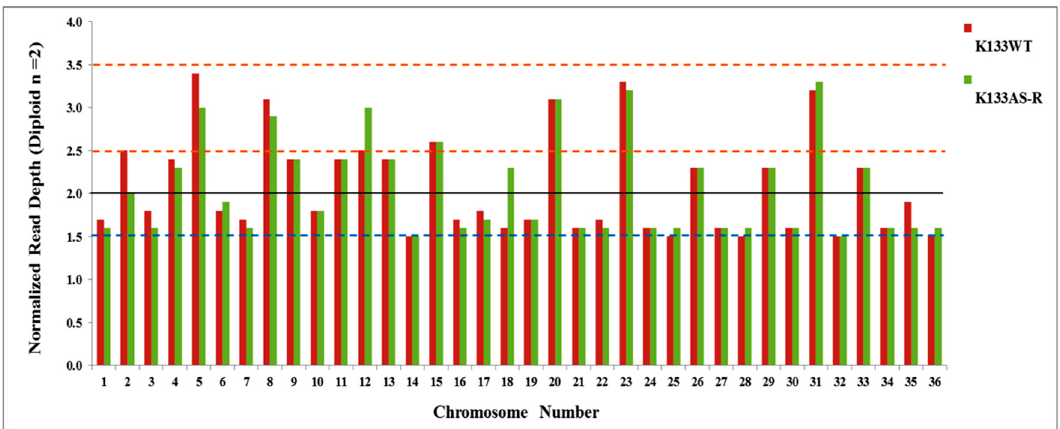
Figure 3. Chromosomy estimation in L. donovani parental line (K133WT) and artemisinin-resistant lines K133AS-R. The solid line represents median coverage and it was assigned a value of 2, considering that diploid is the principal ploidy state in Leishmania . The dotted line represents the calculated values for other somies (blue- monosomy; between two dotted red-trisomy).